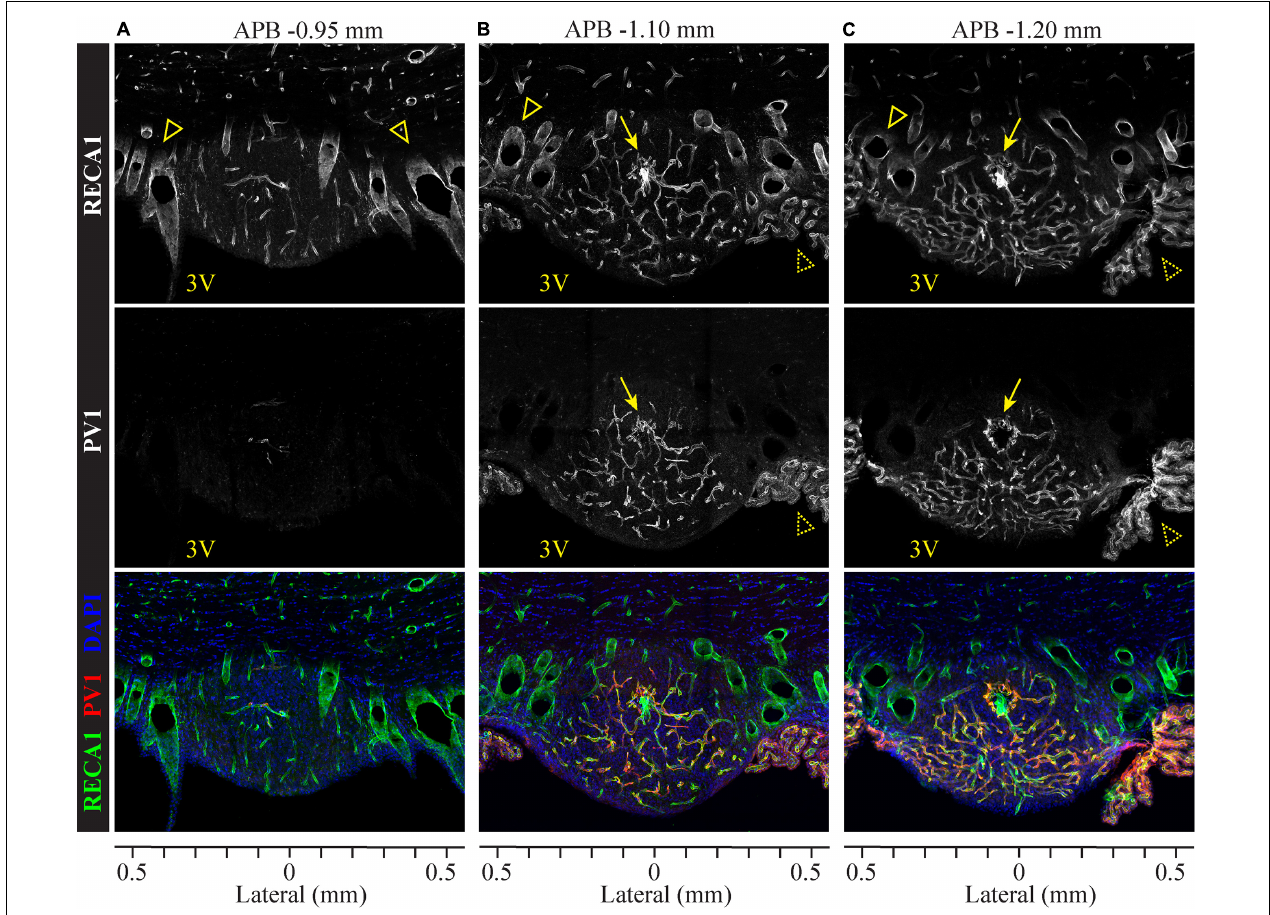
FIGURE 2 | Organization of fenestrated and non-fenestrated vasculature in the SFO analyzed in coronal plane. Distribution of immunolabeled markers for fenestrated and non-fenestrated endothelium in rostral (A) , medial (B) and caudal (C) SFO sections. Pan-endothelial marker RECA1 (rat endothelial cell antigen) is immunostained to visualize all vasculature (white in top panels, green in bottom panels), plasmalemmal vesicle-associated protein 1 (PV1) labeling shows fenestrated vessels (white in middle panels, red in bottom panels), and DAPI (blue, bottom sections). Anterior-posterior bregma (APB) are indicated above and lateral coordinates are shown under each column. PV1-positive fenestrated capillaries are abundant in the medial and caudal sections (B,C) , but almost not found in the rostral SFO section (A) . Also note the absence of PV1 staining in the subfornical artery (arrows) and septal veins (open arrowheads). Choroid plexus (dotted arrowheads) contains PV1-positive fenestrated